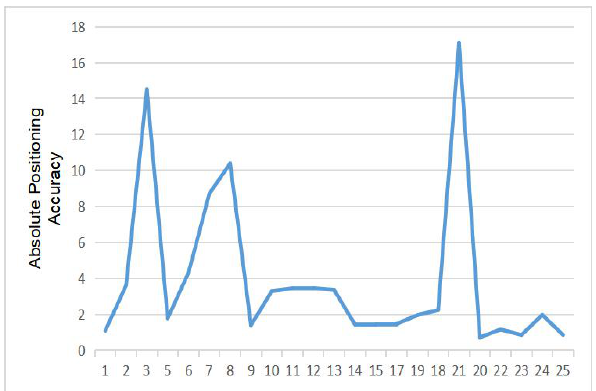
Figure 3. Absolute accuracy variation for Austrila